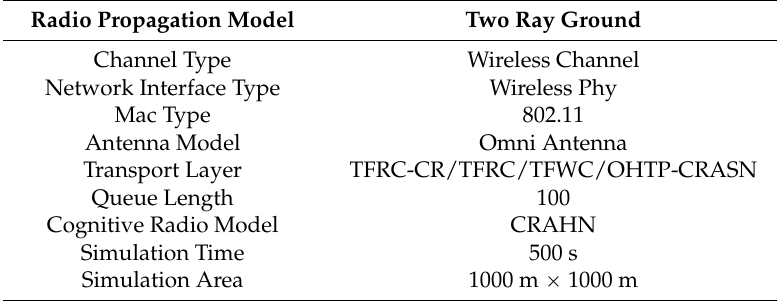
Table 1. Simulation